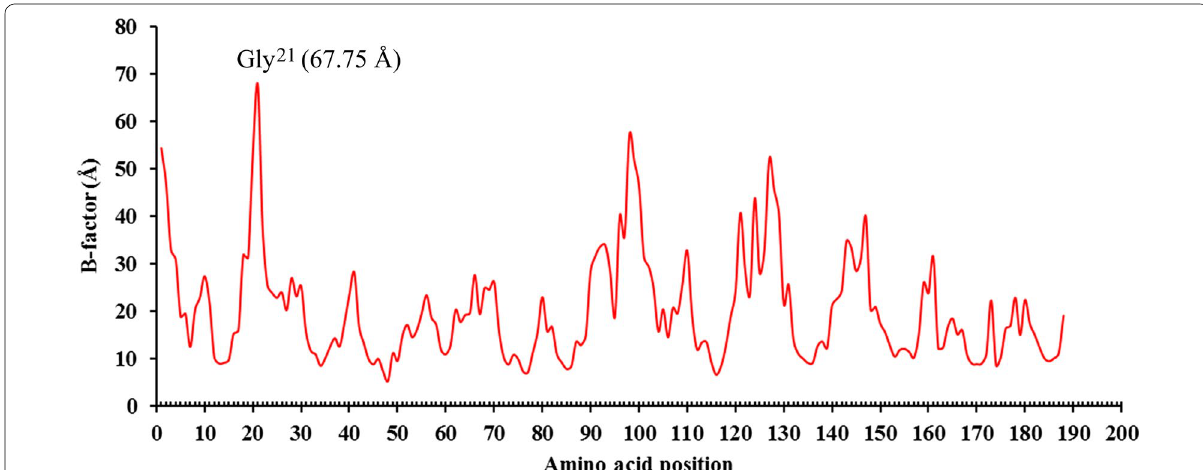
Fig. 1 The B‑factor values of amino acid residues in AoXyn11A. The modeled 3‑D structure of AoXyn11A was subjected to MD simulation at 300 K for 15 ns. Gly 21 in position 21 with the maximum B‑factor value of 67.75 Å was marked